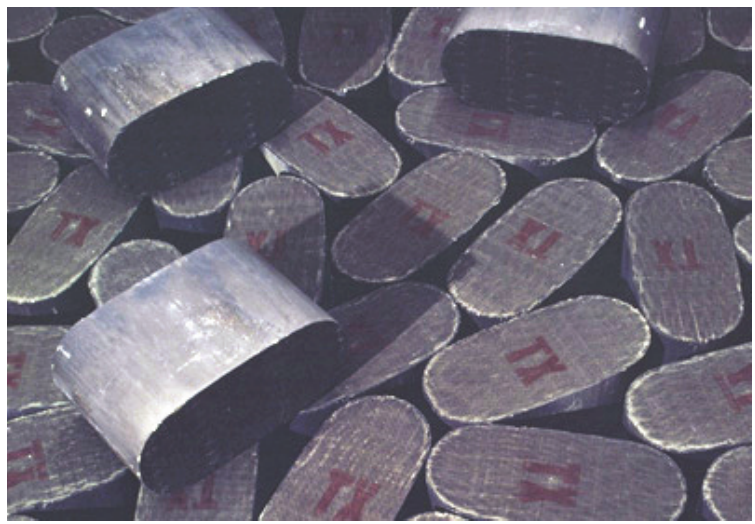
Figure 1: A pile of platinum-lined catalytic converters (source: Amos, 2009: